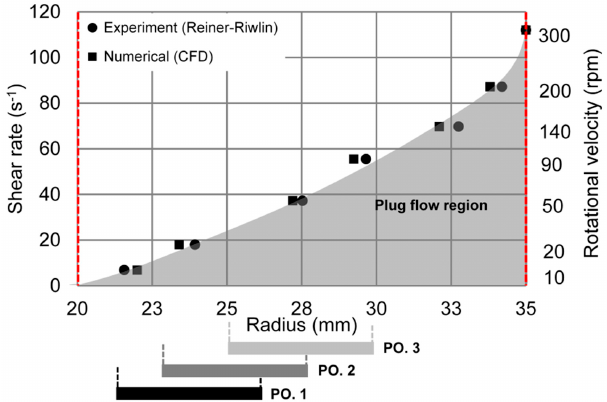
Figure 6. Plug flow radii over the shear gap determined by the analytical model and CFD simulations at different rotational velocities and its effect on different FBRM measurement zones.